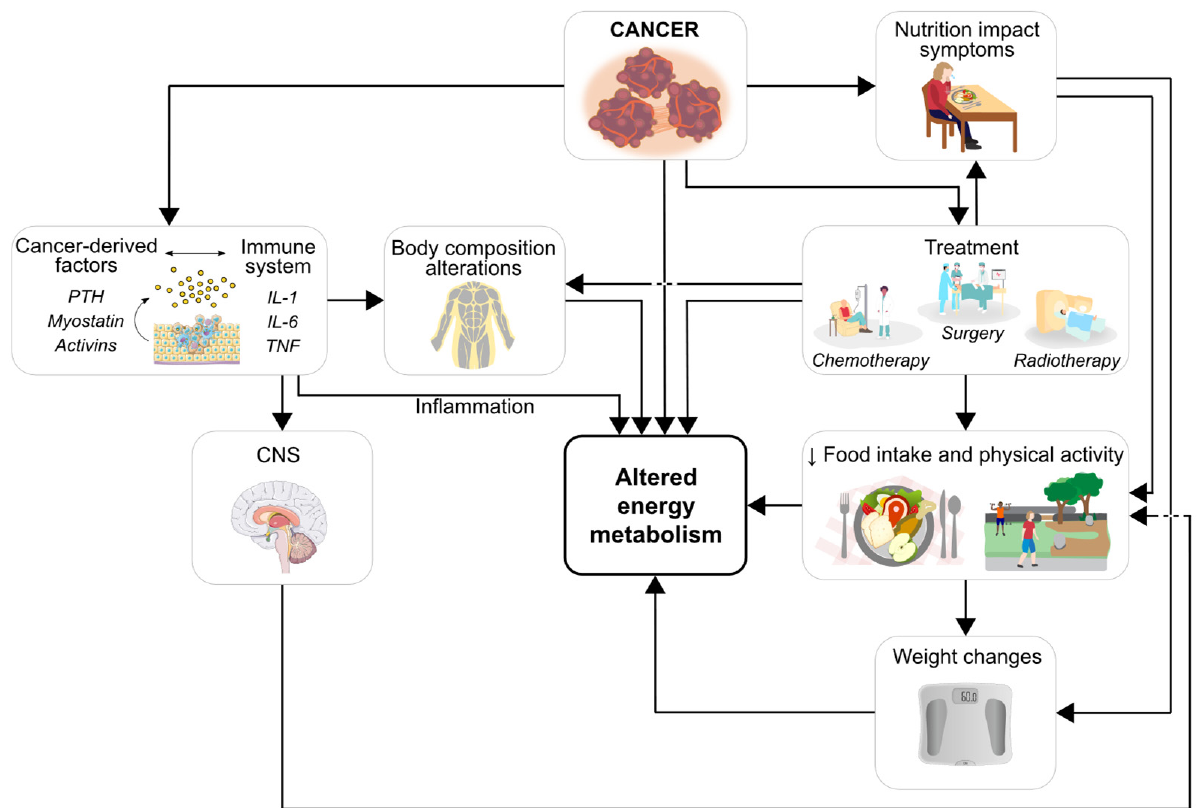
Figure 1. Cancer (including gynecological cancers), with or without the presence of metastasis, may lead to altered energy metabolism. Arrows indicate select pathways that contribute to this process. Cancer stimulates the secretion of cancer-derived factors (e.g., PTH, myostatin, and activins) that interact with the immune system, promoting the secretion of pro-inflammatory cytokines (e.g., IL-1, IL-6, and TNF). The resulting inflammatory state may directly or indirectly impact energy metabolism. Indirect changes happen through alterations in body composition and/or in the balance of orexigenic and anorexigenic neuropeptides in the CNS. Changes in this balance may lead to decreased food intake and levels of physical activity. Cancer and/or its treatment may induce nutrition impact symptoms (e.g., nausea, loss of appetite, constipation, diarrhea) that can also lead to reduced food intake and physical activity patterns, which in turn can promote weight changes. In summary, cancer, its treatment (and associated side-effects), inflammatory status, body composition alterations, reduced food intake and physical activity, and weight changes may lead to altered energy metabolism in cancer. PTH, parathyroid hormone; IL-1, interleukin-1; IL-6, interleukin-6; TNF, tumor necrosis factor; CNS, central nervous system. Images retrieved from smart.servier.com (accessed on 5 May